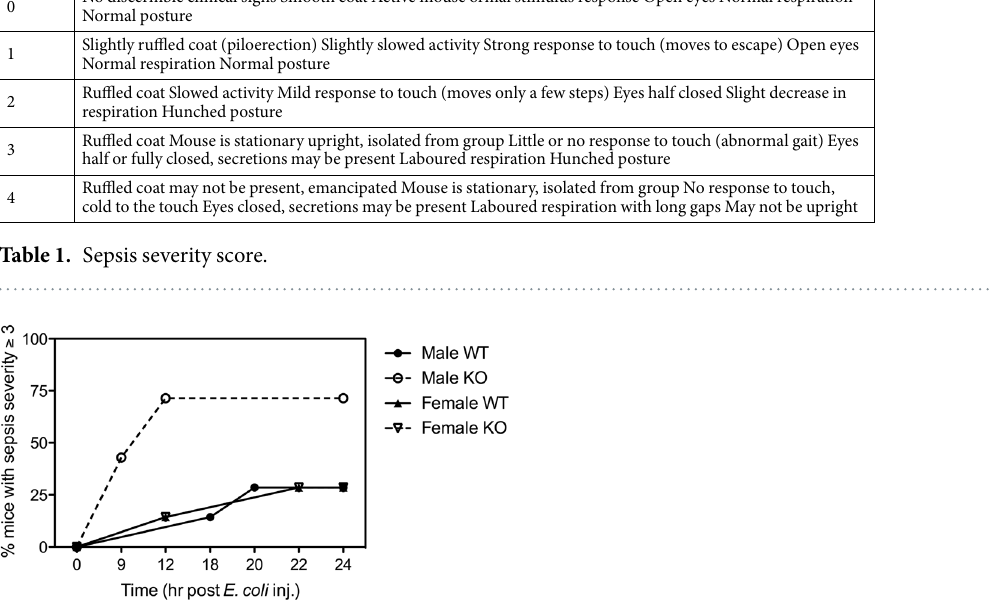
Figure 1. β 2GPI confers protection against gram-negative bacterial septicaemia in male mice. Septicaemia clinical severity time course over 24 h of male and female WT and β 2GPI − / − mice following intravenous administration with 10 8 CFU of E. coli . Mice were euthanized when they reached a severity score of ≥ 3. A greater percentage of male β 2GPI − / − developed severe septicaemia compared to male WT mice following E. coli injection ( n = 7 per group, p = 0.02, Gehan-Breslow-Wilcoxon Test). There was no difference in septicaemia clinical severity score between female WT and female β 2GPI − / − mice. Male WT = ● , Male β 2GPI − / − = ○ , Female WT = ▲ , Female β 2GPI − / − = ▽